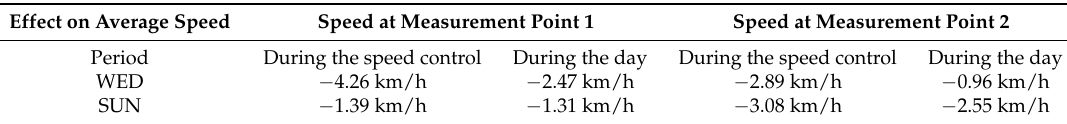
Table 7. Effect during the speed control in regional police unit